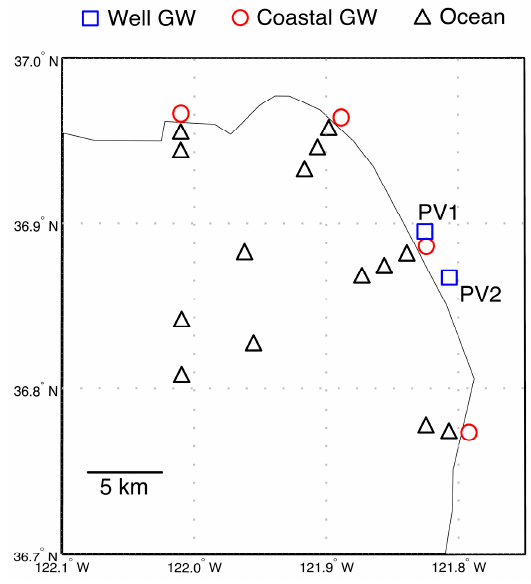
Figure 1. Sampling locations in Monterey Bay, CA. Samples were collected from monitoring wells (Well GW, PV1 and PV2), the coastal aquifer (Coastal GW), and Monterey Bay itself (Ocean). Symbols are consistent across all figures.